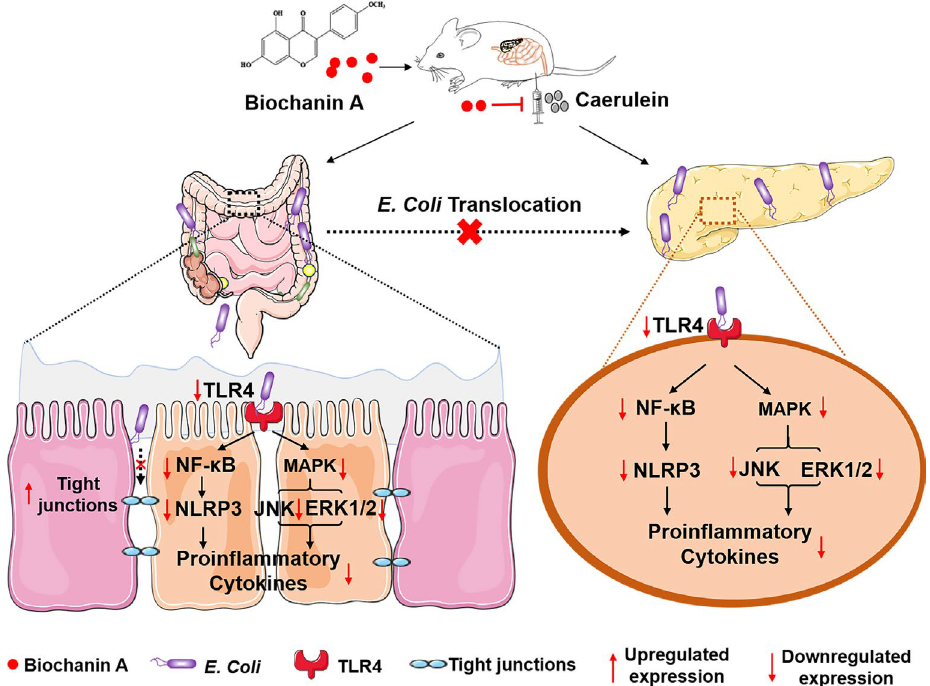
Figure 5. Mechanisms of BCA to prevent AP and intestinal injury. Reprinted with permission from Ref. [37].